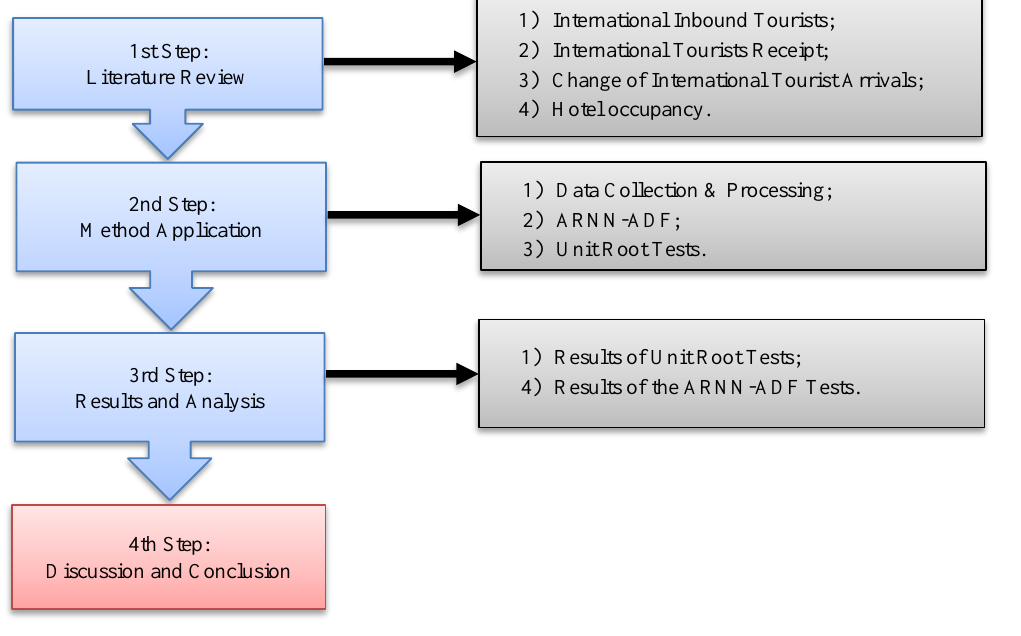
Figure 1. Flowchart of Research